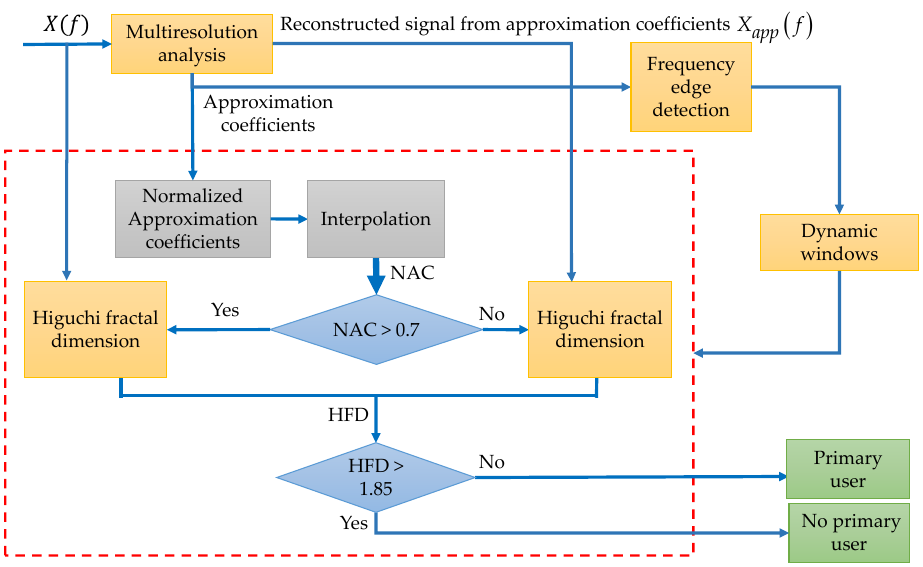
Figure 8. The second methodology described by a flow diagram.